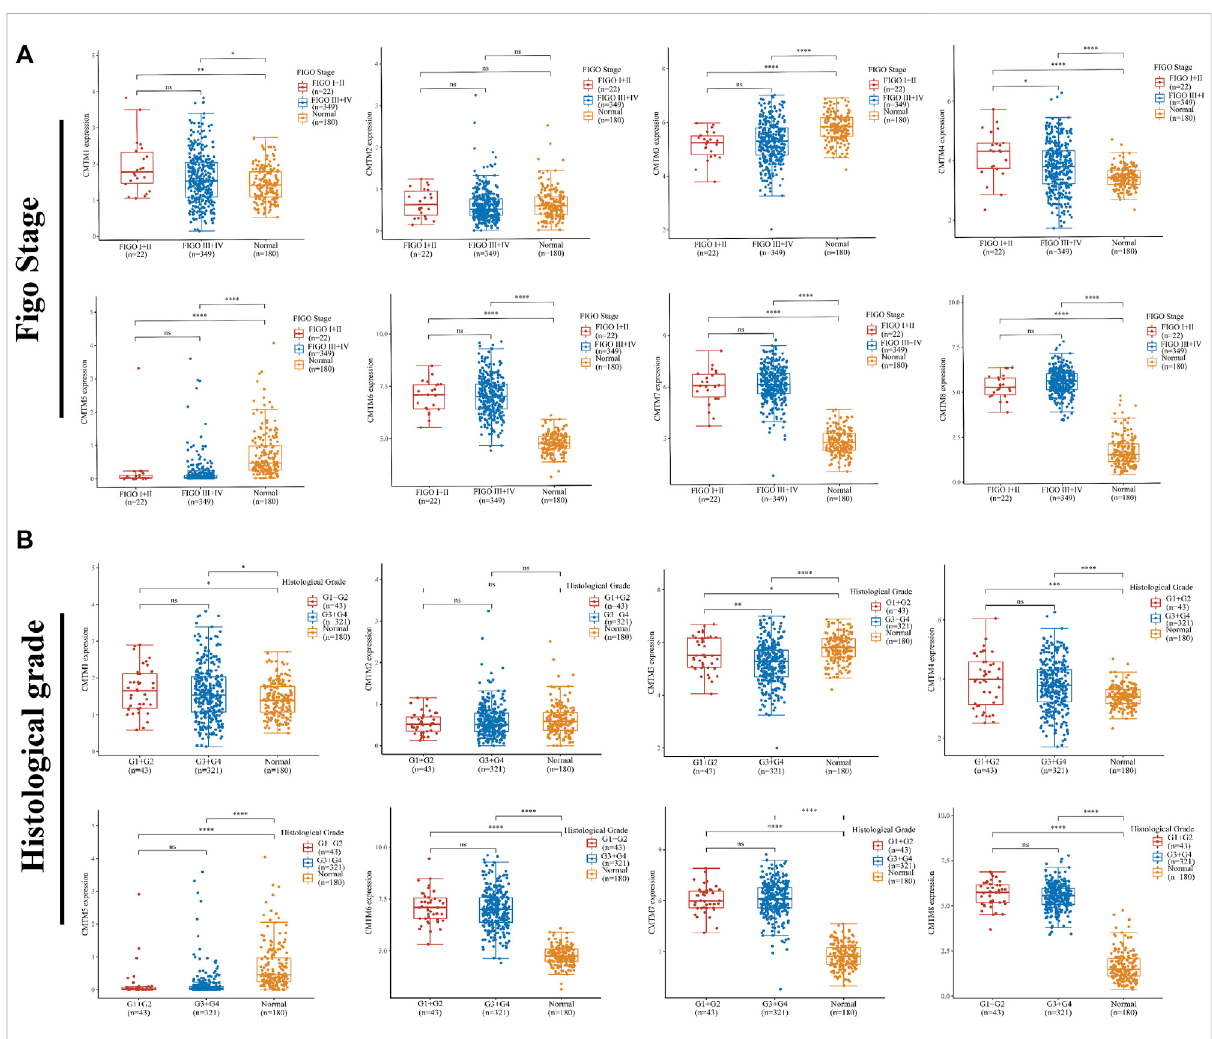
FIGURE 4 The relationship between the expression levels of each member of the CMTM family and different clinical characteristics. (A) Differences in mRNA expression levels of CMTMs in different FIGO stages (I + II = 22, III + IV = 349, normal = 180). (B) Differences in mRNA expression levels of CMTMs of different histological grades (G1+G2 = 43, G3+G4 = 321, normal = 180). * p < 0.05; ** p < 0.01; *** p <